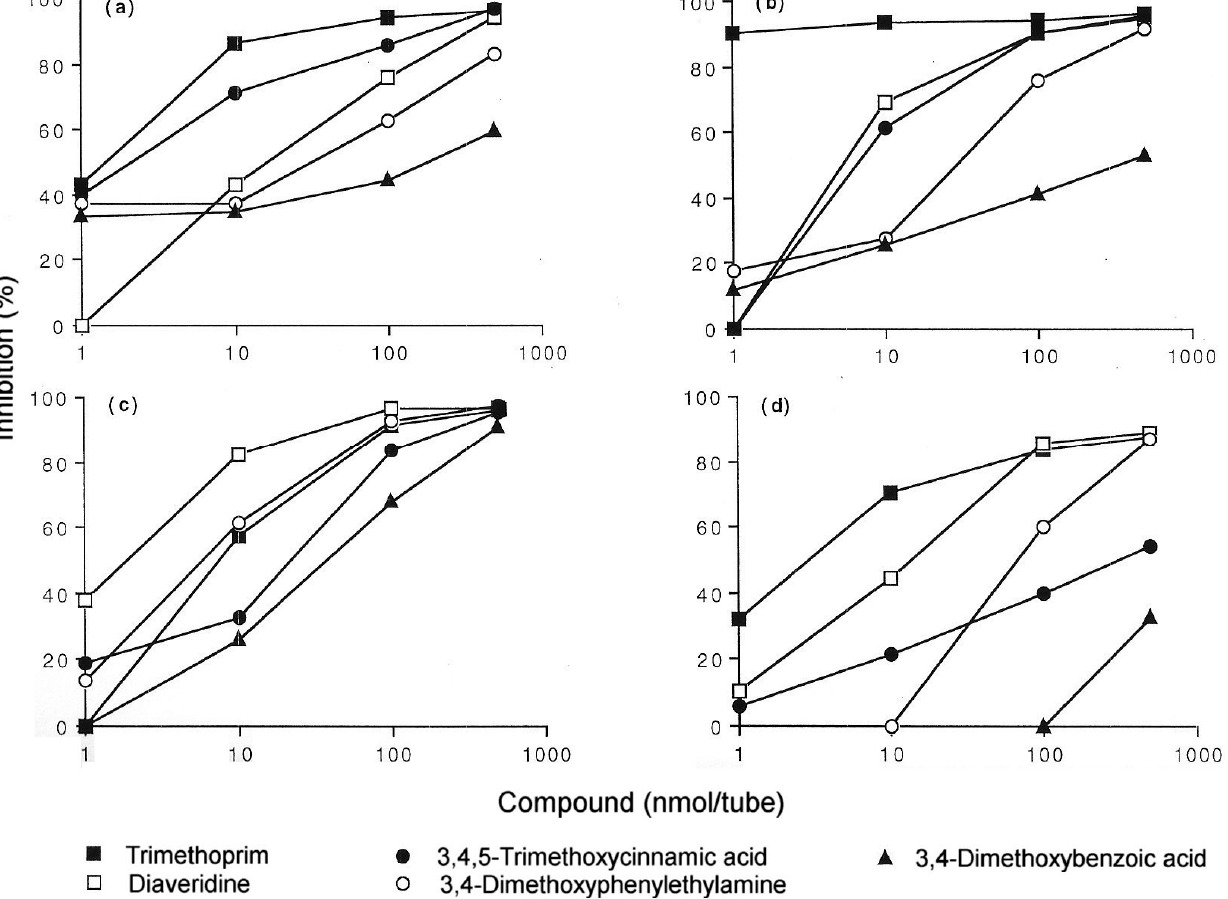
Figure 12. Three allergenic (IgE antibody-binding) determinants of trimethoprim identified so far in sera from patients showing immediate type I reactions to the drug.